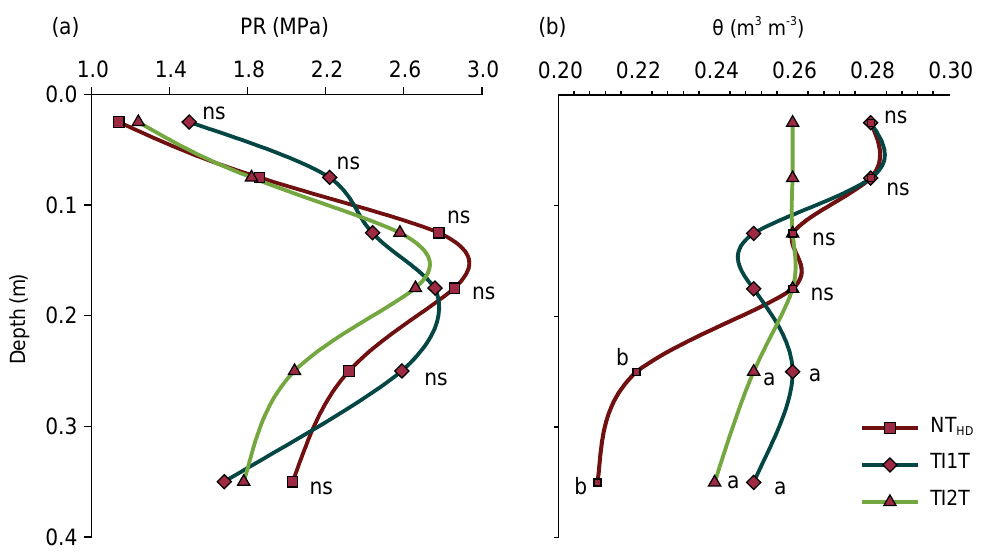
Figure 8. Soil penetration resistance (PR) (a) and volumetric water content (θ) (b) in treatments with no traffic (NT HD ) and after 1 and 2 pivoting maneuvers (TI1T and TI2T) of M113 BR in a straight line. ns: not significant by Tukey test (5